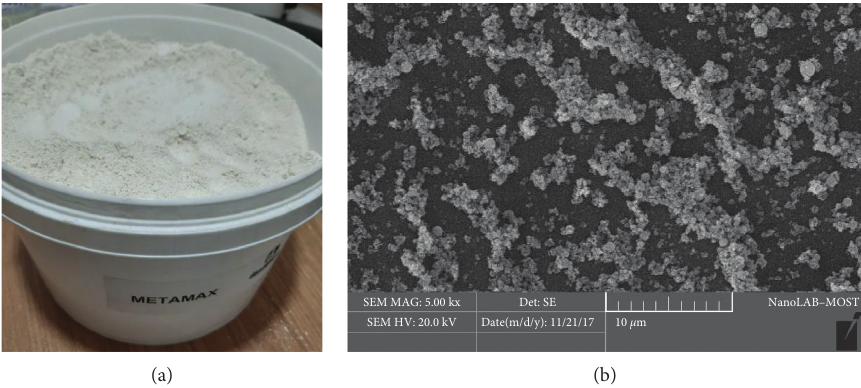
Figure 1: Metakaolin used in current study. (a) Metakaolin powder. (b) Scanning electron microscopy image. Table 3: Mix designation and